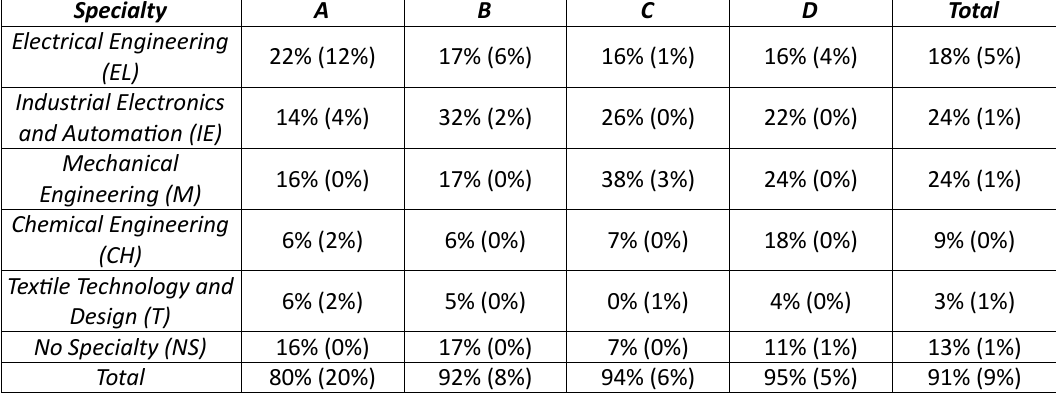
Table 4. Academic year 2012/13 – Percentages of the distributon of students passing the course (the percentage of students failing the course is indicated in parentheses), by group and specialty